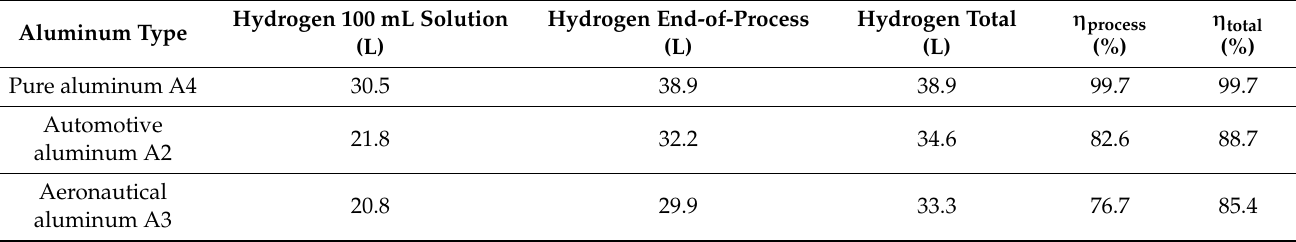
Table 8. Hydrogen flow rate generated for 100 mL of 7.5 M NaOH solution in an alcoholic medium. Hydrogen flow is generated at the end of the process or reaction in an alcoholic medium, isopropyl alcohol. Total flow rate by adding 7.5 M NaOH solution in a non-alcoholic medium. Yields of the alcoholic process and total non-alcoholic yield related to stoichiometric yield with 100% pure